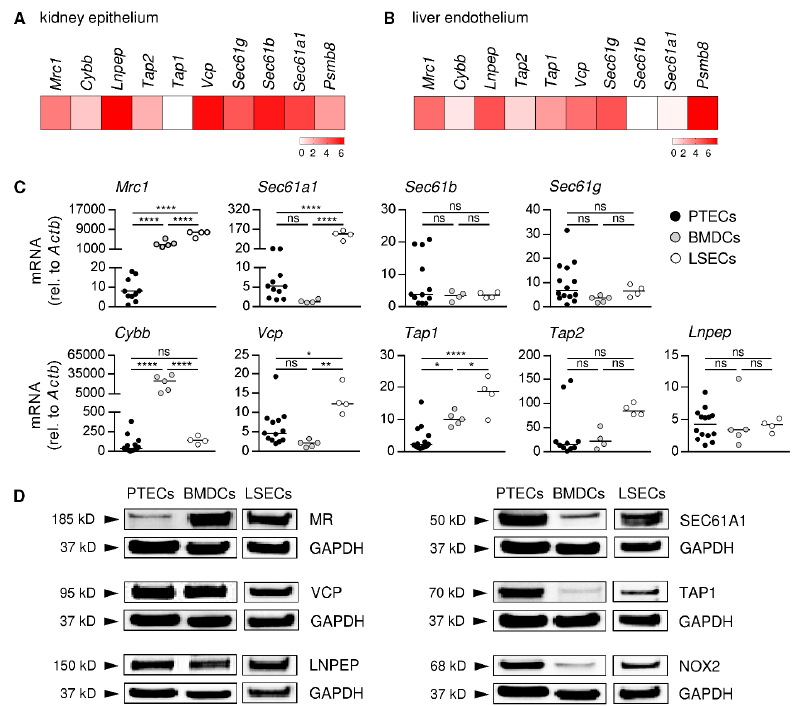
Figure 1. Gene and protein expression analysis of markers associated with antigen cross- presentation. RNA-seq data were used to create a gene set expression analysis of ( A ) renal epithelial cells and ( B ) liver endothelial cells. The Log 2 cpm data sets were depicted in heat maps. ( C ) Gene expression profiles of PTECs, DCs, and LSECs were assessed by quantitative RT-PCR and normalized to the reference gene β -actin ( Actb ). Medians of at least four experiments are shown. ( D ) PTEC, DC, and LSEC protein expression levels were determined by a WB analysis and depicted in relation to expression of the reference protein GAPDH. Blots are representative of two experiments. * p < 0.05; ** p < 0.01; **** p < 0.0001; ns: not significant.